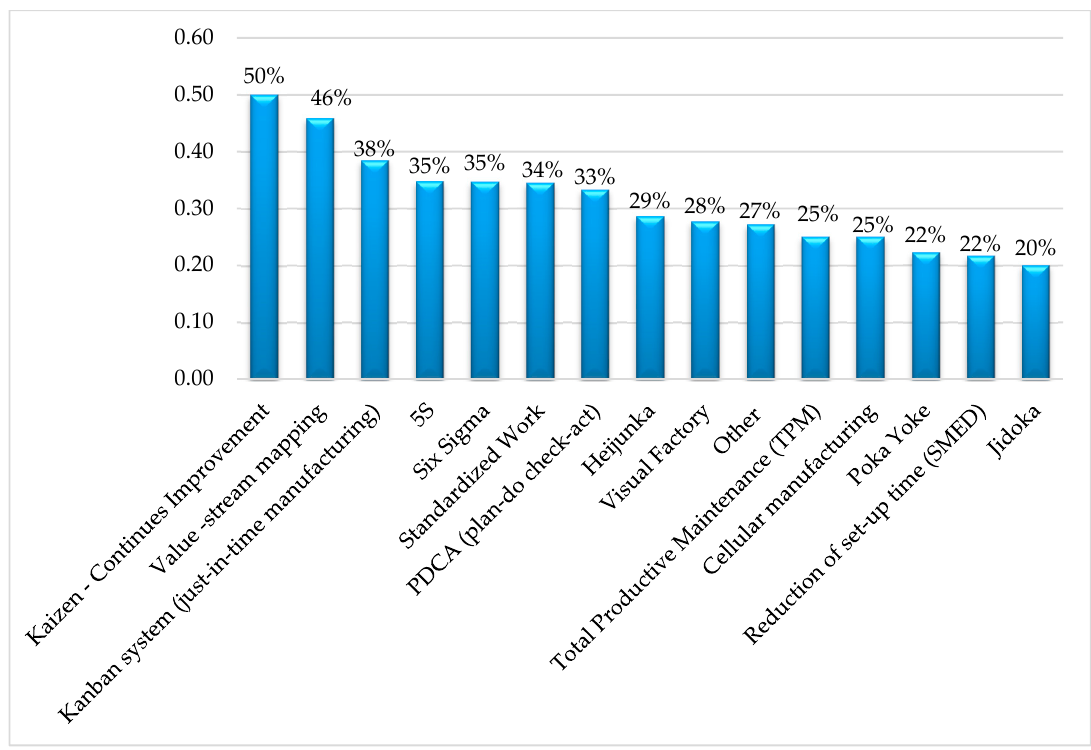
Figure 4. The average of all numbers about Lean Manufacturing Techniques (LMTs) that have helped the most companies.